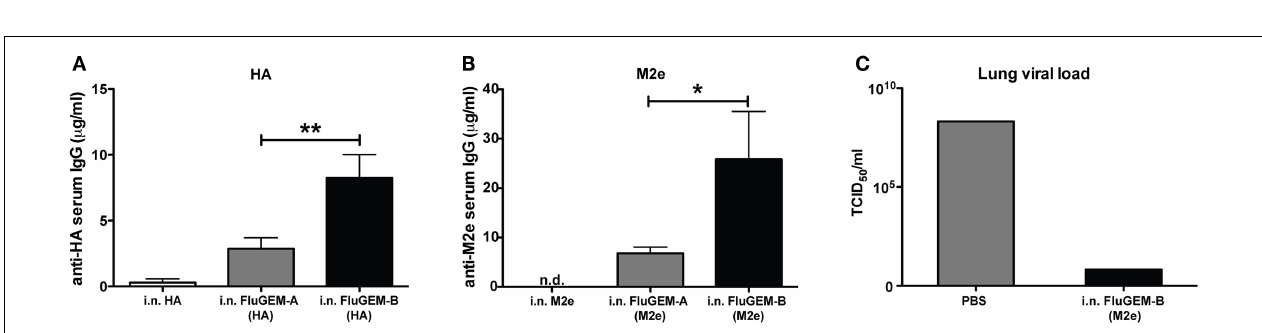
FIGURE 4 | Biological activity of trimeric and monomeric HA-Protan fusion protein bound to BLPs (FluGEM-B) expressed as hemaggluti nation capacity (HAU) .Trimeric HA bound to BLPs displays a high capacity